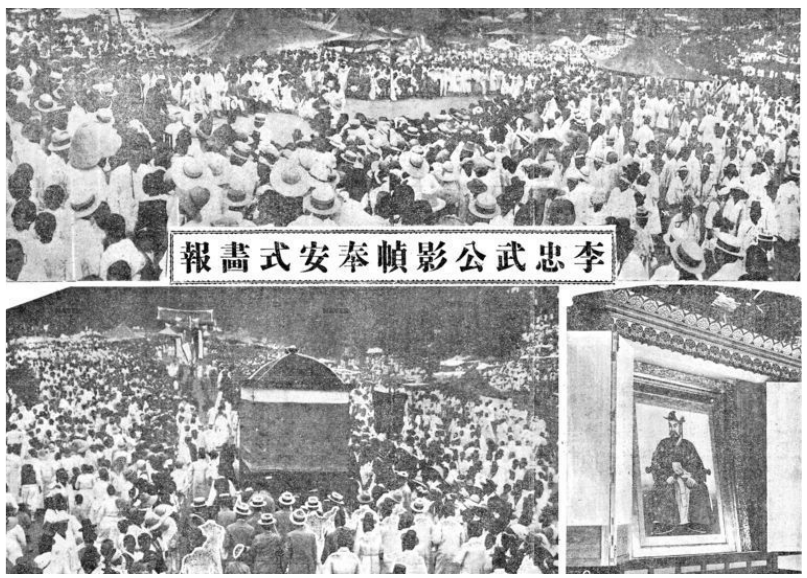
Figure 16. Enshrinement Ceremony for Admiral Yi Sun-sin’s Portrait at the Hyeonchungsa Shrine (source: Dong-A Ilbo, 7 June 1932).